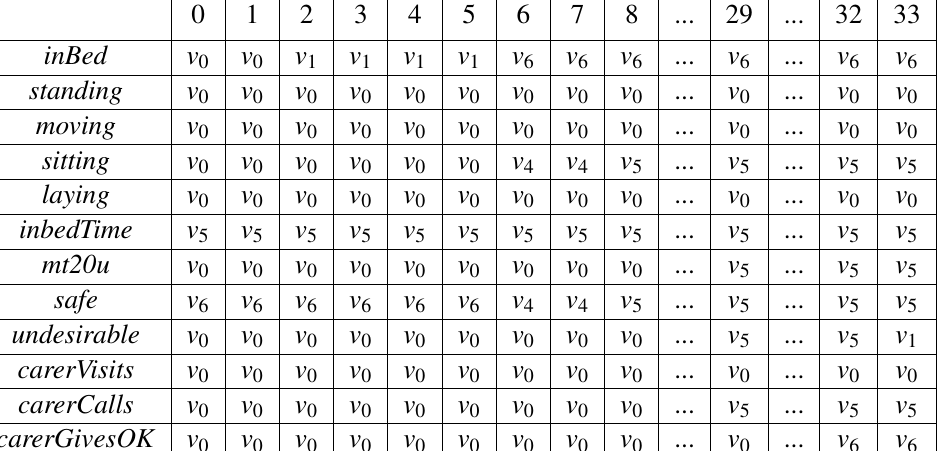
Table 1. Scenario 1 by Forward Reasoning